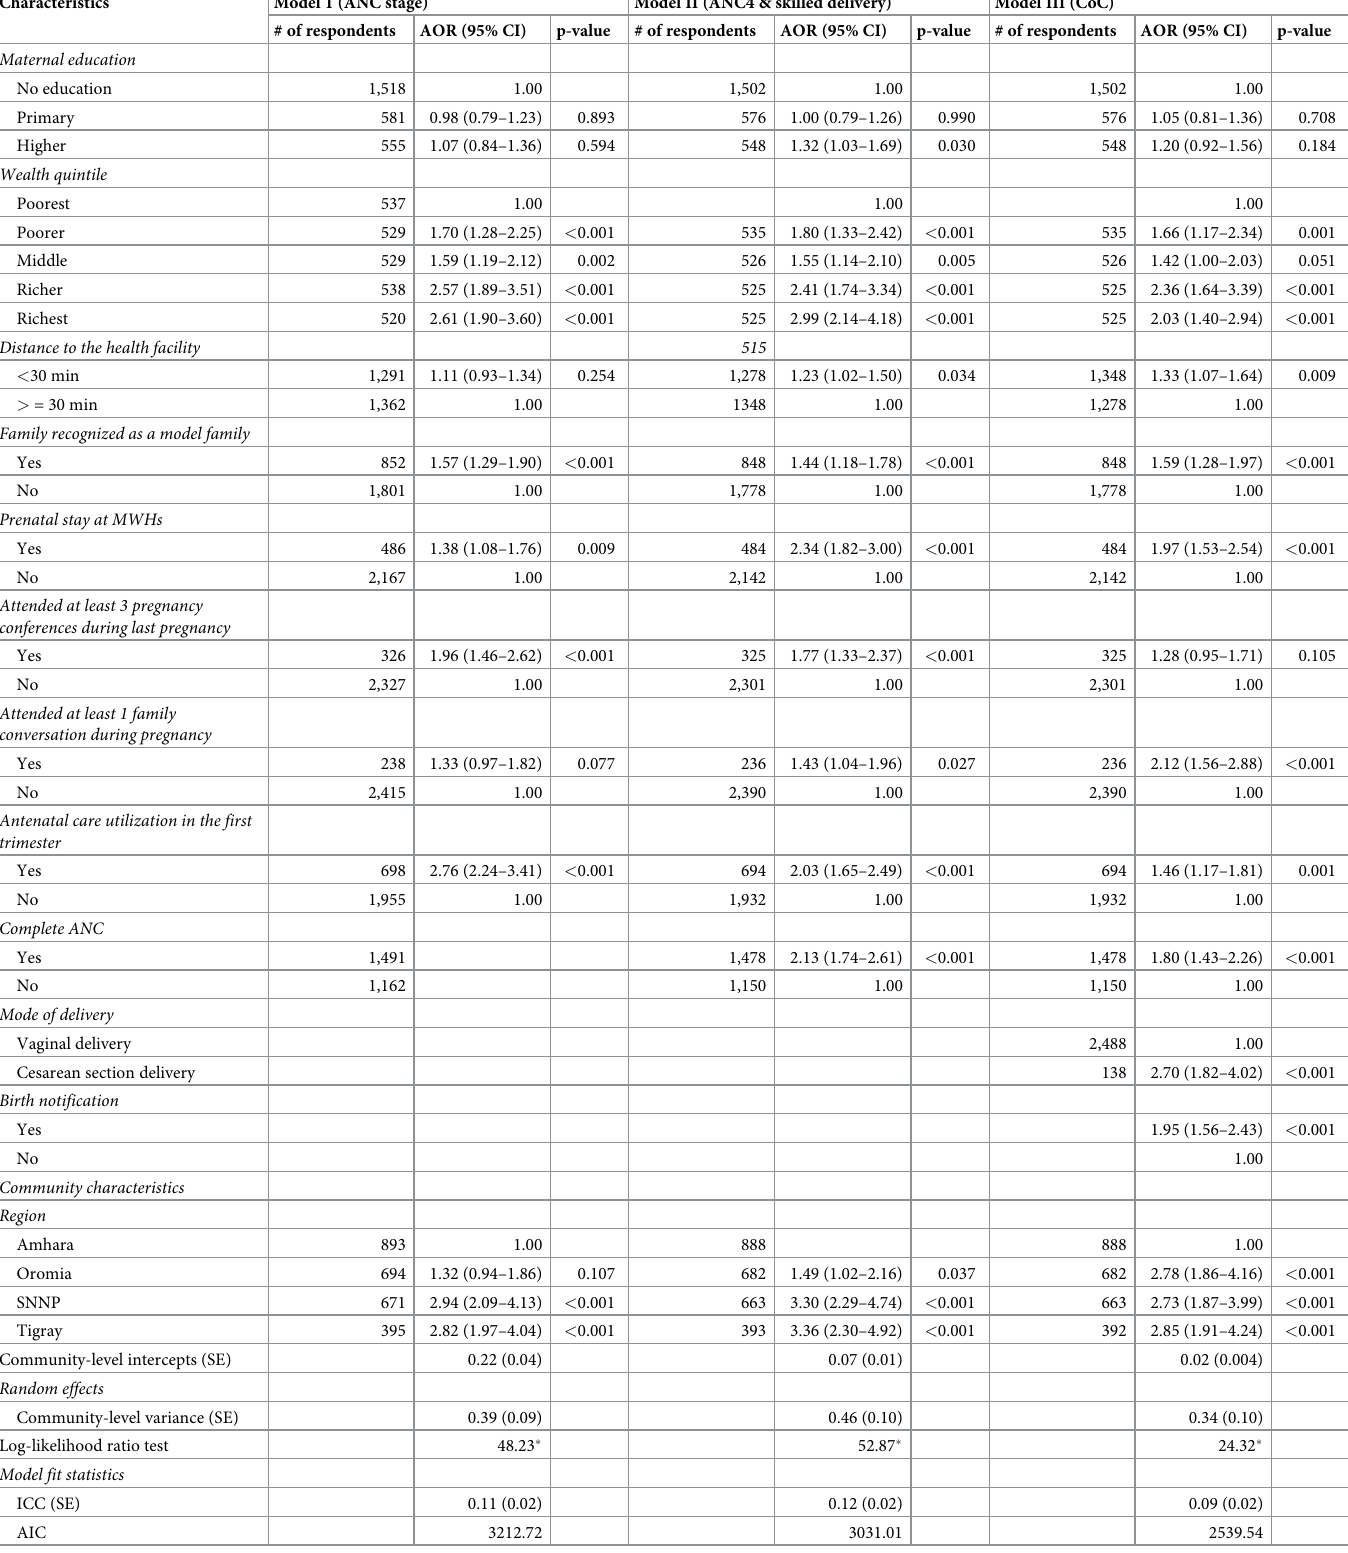
Table 5. Factors associated with the CoC at antenatal, delivery, and postnatal care in Ethiopia, 2017.